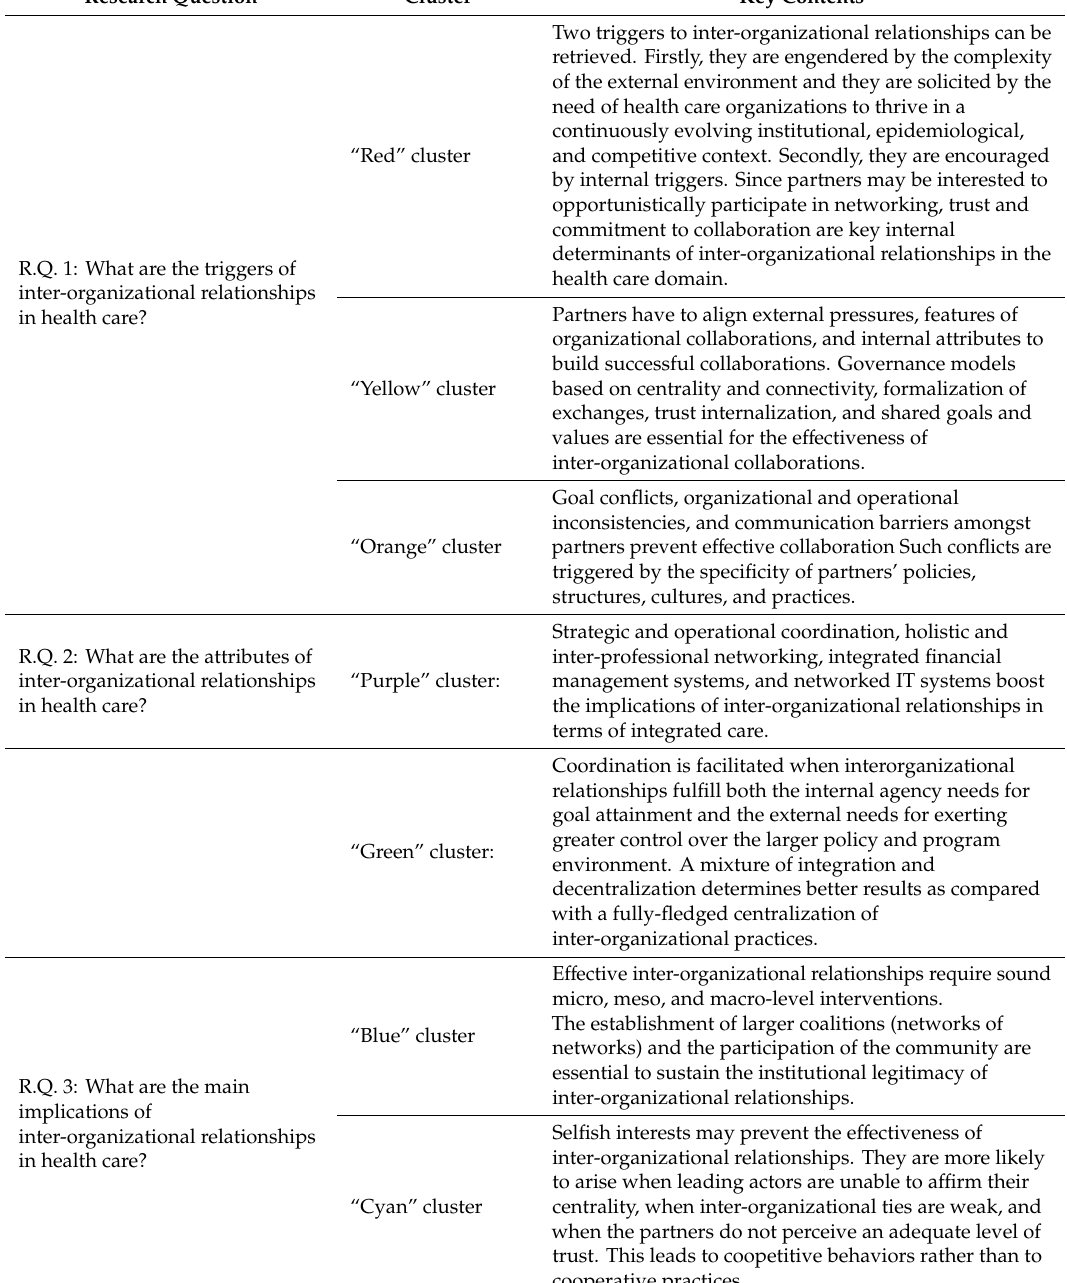
Table 1. An overview of the research items’